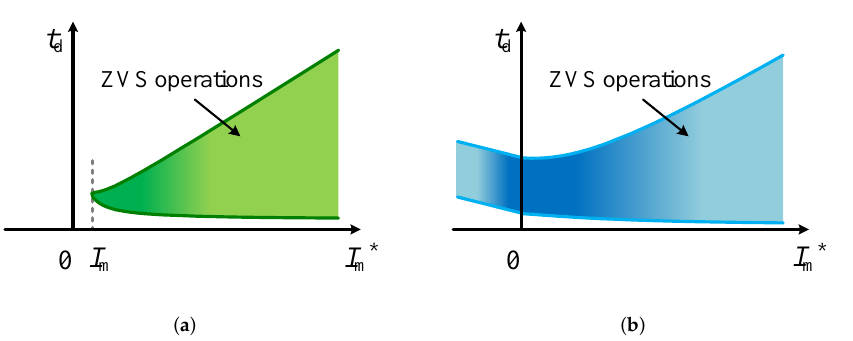
Figure 6. Schematic view of the range of dead-time durations, t d , as function of I m ∗ in the conditions of ( a ) E dc > 0 and ( b ) E dc < 0.